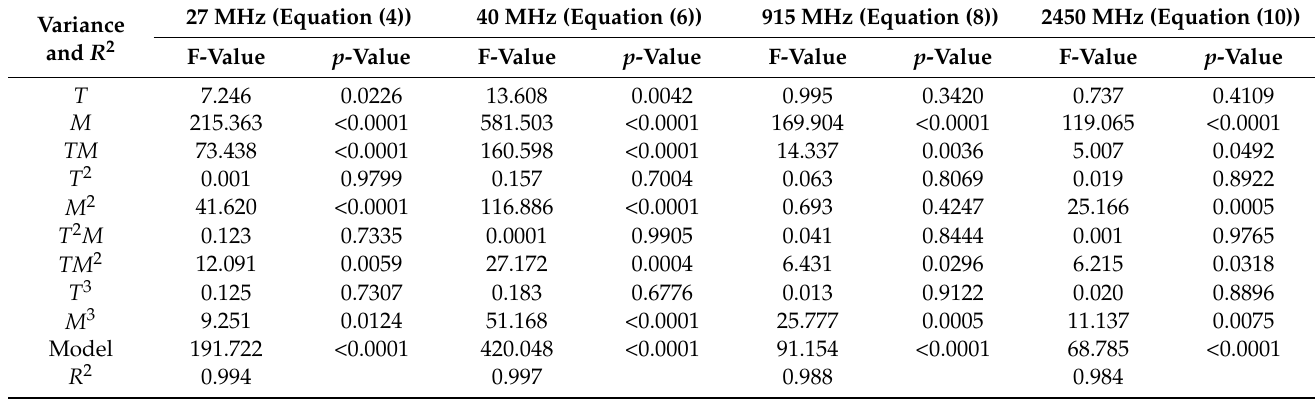
Table 3. Analysis of variance of regressed models of Equations (4), (6), (8), and (10) for wolfberries at four frequencies relevant to dehydration.